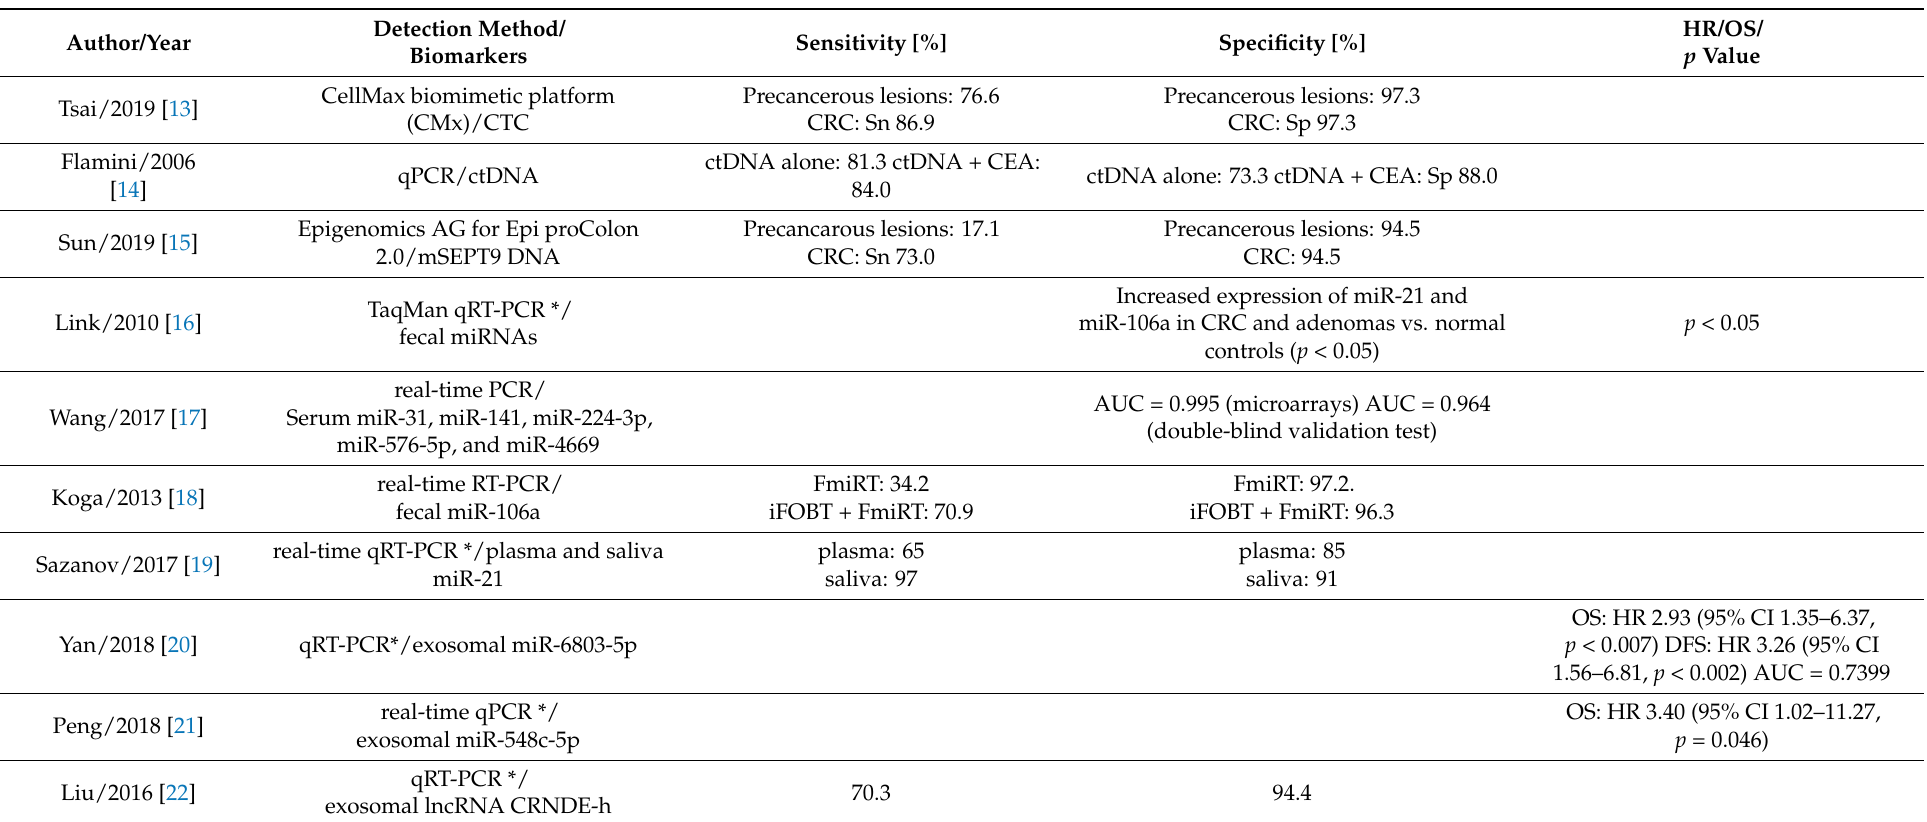
Table 1. According to Vacante in modification: screening/diagnostics liquid biopsy biomarkers in CRC